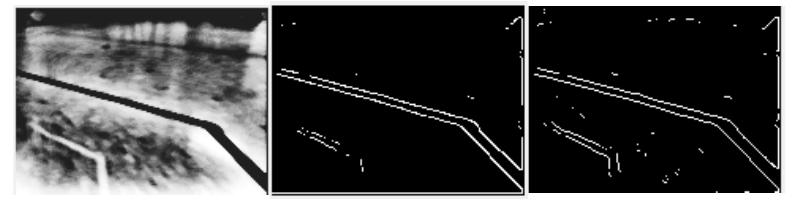
Figure 6. The programmed image.